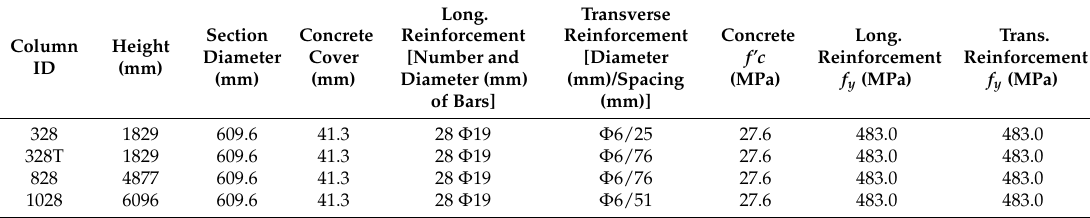
Table 2. Main geometrical and mechanical properties of specimens tested by Calderone and Lehman [27].